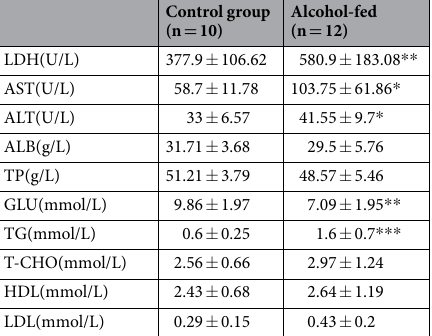
Table 1. Serum biochemical indexes of 12-month-old mice were subjected to chronic alcohol feeding. LDH, lactate dehydrogenase; AST, aspartate aminotransferase; ALT, alanineaminotransferase; ALB, albumin; TP, total protein; GLU, glucose; TG, triglycerides; T-CHO, total cholesterol; HDL-C, high-density lipoprotein cholesterol; LDL-C, low density lipoprotein cholesterol. Means ± SD. Control group, n = 10; Alcohol-fed